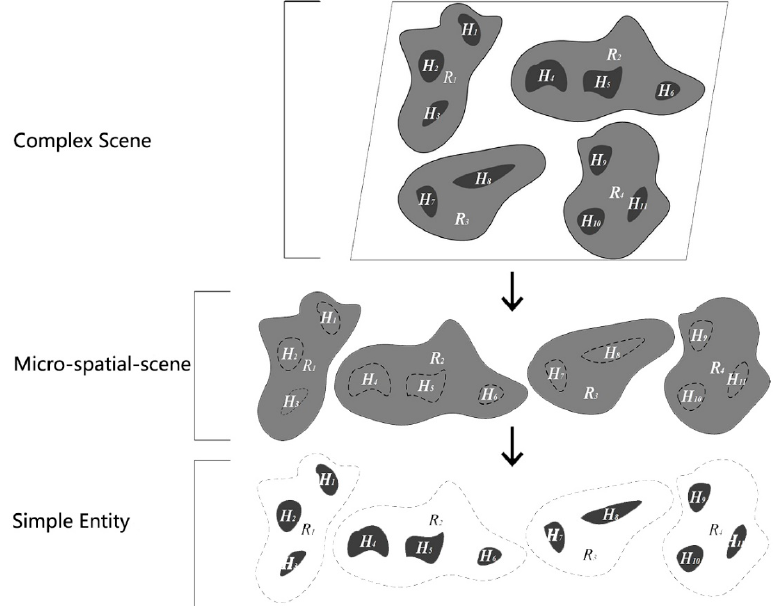
Figure 1. Hierarchical decomposition of a complex scene.